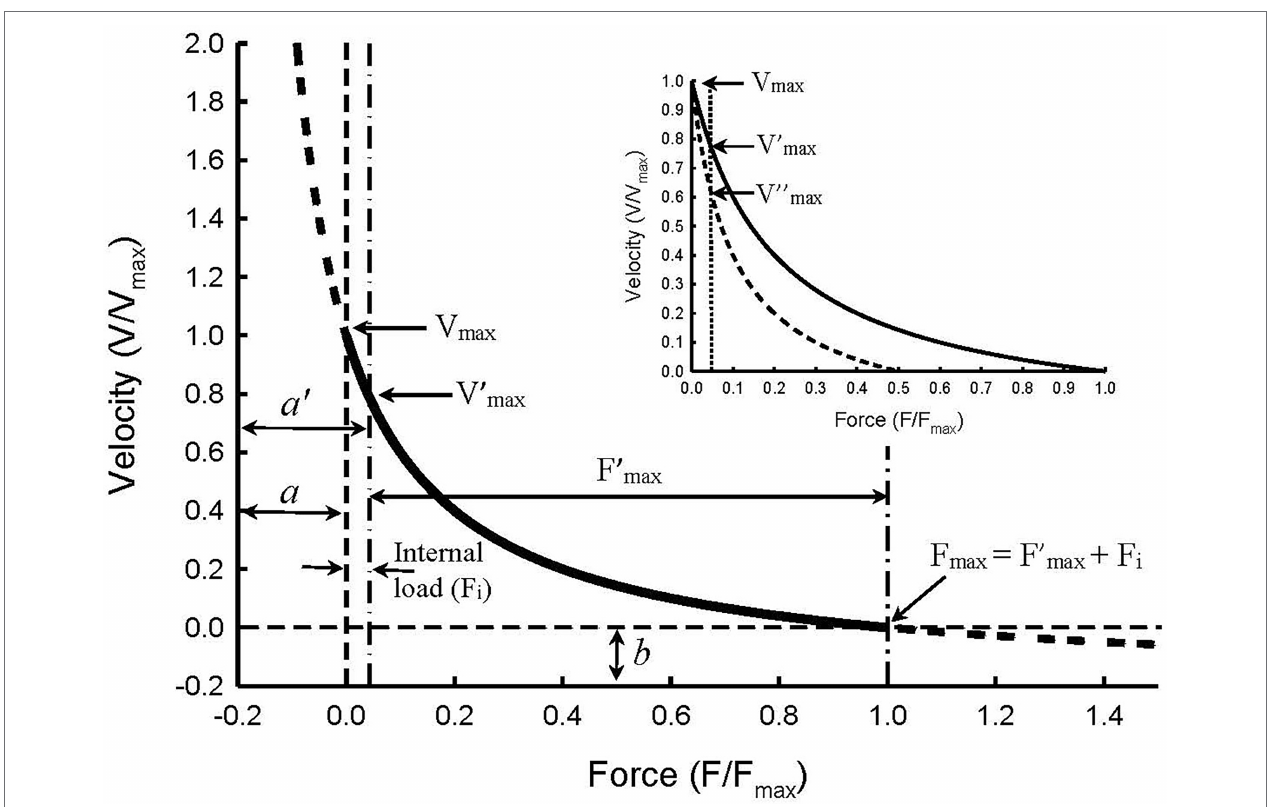
FIGURE 5 | Illustration of force–velocity relationship in the presence of an internal load of 0.05 F max magnitude. The Hill constants a and b are asymptotes of the hyperbolic curve. An internal load effectively increases constant a so that the new asymptote a ’ equals a + F i . The internal load also reduces maximal isometric force so that F’ max equals F max – F i . The apparent force–velocity curvature (F’ max / a ’) decreases in the presence of an internal load, compared with the curvature in the absence of the internal load (F max / a ), because F’ max / a ’ = (F max – F i )/( a + F i ). The maximal velocity seen in the absence of both internal and external loads (V max ) is not affected by the internal load. However, the internal load causes an apparent decrease in the maximal velocity (from V max to V’ max ). Inset: Illustration of how partial activation in the presence of an internal load causes an apparent decrease in the maximal velocity from V’ max at full activation to V ″ max at half-activation. The changes in V max , F max , and F max / a due to an internal load are called “apparent” because the changes are artifacts caused by the internal load and not by changes in the kinetics of actomyosin